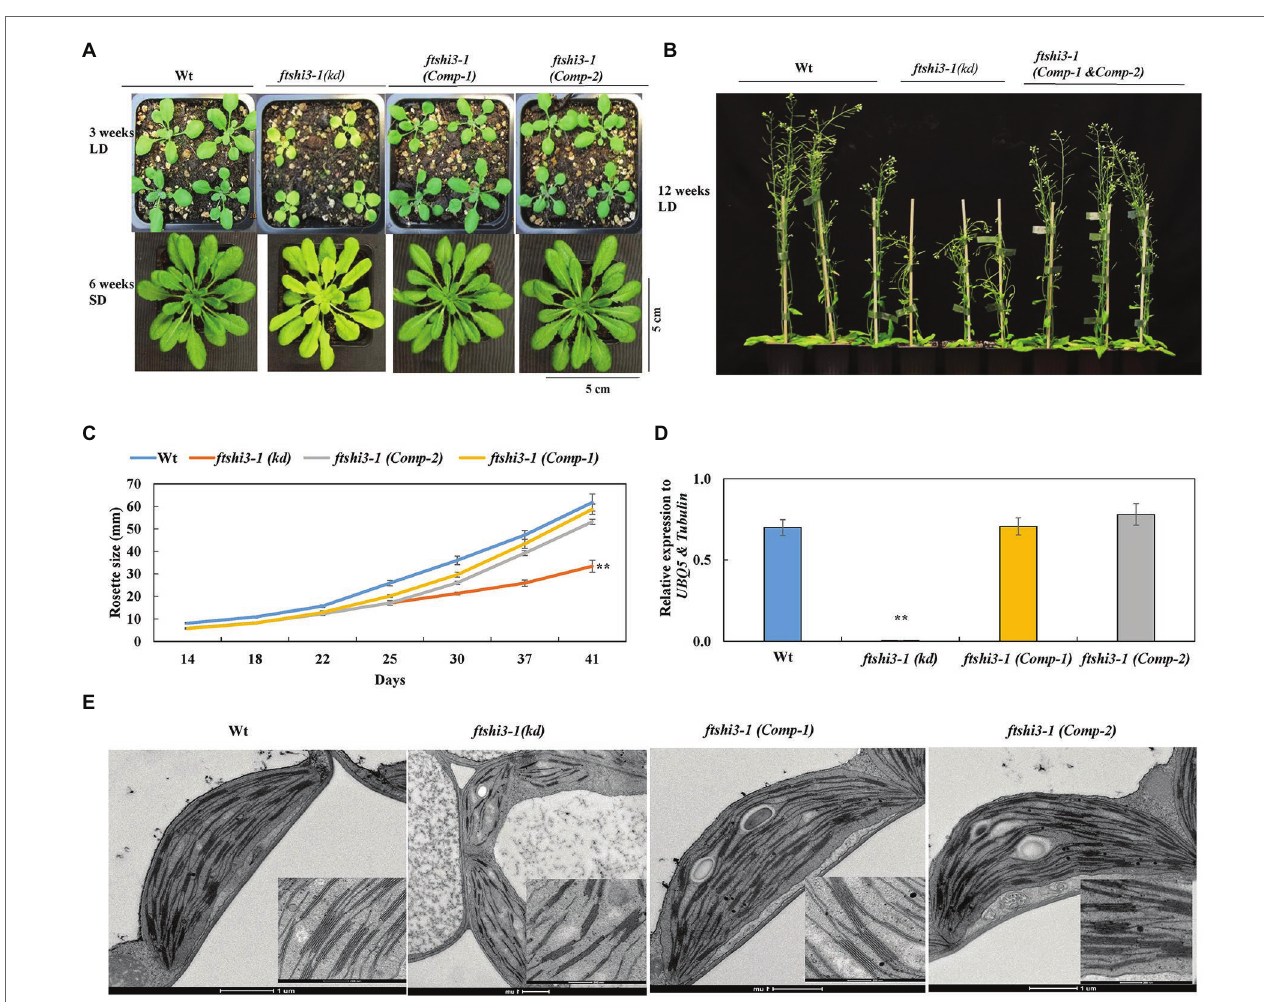
FIGURE 2 | (A) Phenotypes of Wt, ftshi3-1(kd) , and ftshi3-1 ( Comp-1 and Comp-2 ) at the age of 3 weeks grown in a long-day (LD; upper panel), 6 weeks in a SD (lower panel) or (B) 12 weeks in LD. (C) Rosette diameter measurements were performed from 2 to 6 weeks grown in SD. Asterisks indicate a significant difference ( ** p < 0.05, Student’s t test, n = 8). (D) FTSHi3 gene expression analysis of Wt, ftshi3-1(kd) , and ftshi3-1 ( Comp-1 and Comp-2 ) lines. Relative expression was normalized to At-UBQ5 and At-Tubulin . Asterisks indicate a significant difference ( ** p < 0.05, Student’s t test, n = 3). Error bars represent the SE. (E) Transmission electron micrographs of chloroplasts of the first true leaves in Wt, ftshi3-1(kd) , and ftshi3-1 ( Comp-1 and Comp-2 ) seedlings. Upper panel bars = 200 nm, lower panel bars = 1 μ